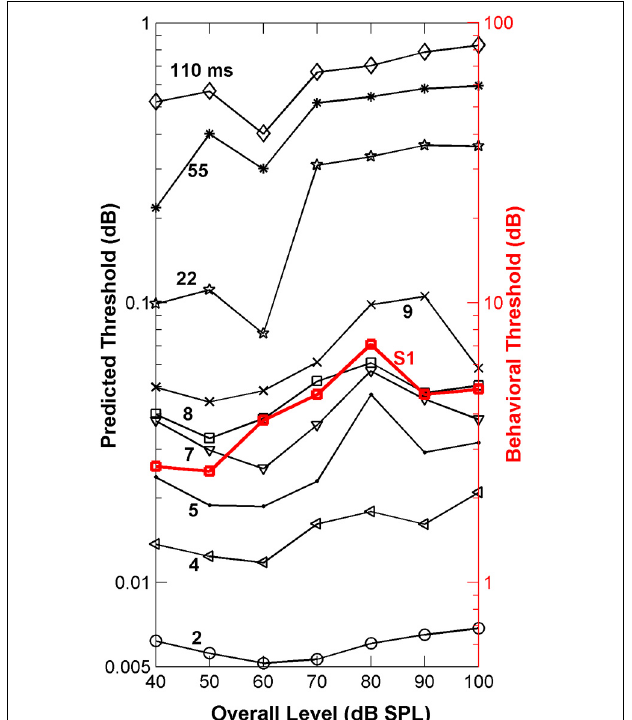
FIGURE 6 | Auditory nerve data: psychoacoustically observed notch-depth thresholds vs . “ideal observer” predictions from neural data. Psychoacoustical (red squares, right ordinate axis) thresholds as a function of noise level for an example listener (S1; Figure 1B ). Predicted thresholds (open symbols, left ordinate axis) were obtained using an “ideal observer” type of analysis of physiological AN responses [Equations (2a) and (2b)]. Different curves illustrate predicted thresholds when AN activity is analyzed over non-overlapping time binwidths of different durations, as indicated by the numbers next to each trace (in ms; adapted from Figure 1 of Lopez-Poveda et al.,